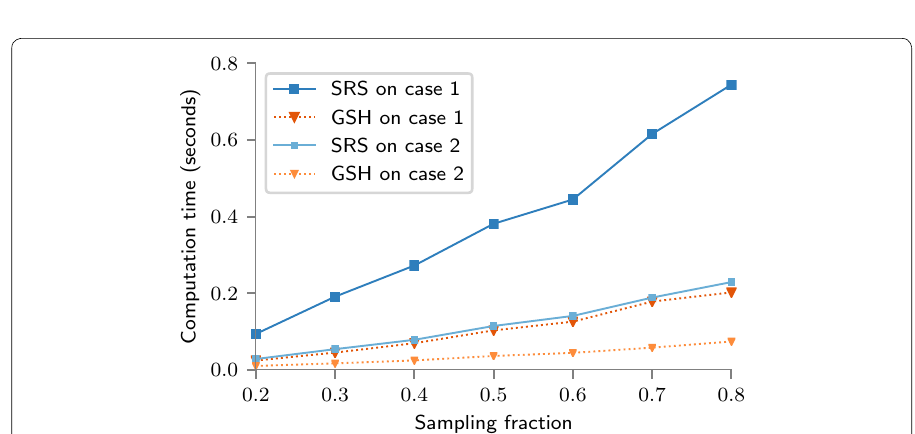
Fig. 15 Compound performance gains from applying GSH after SRS